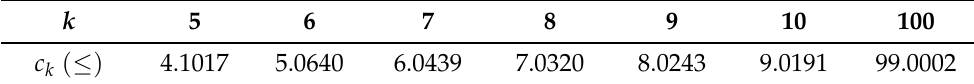
Table 3. Some values of c